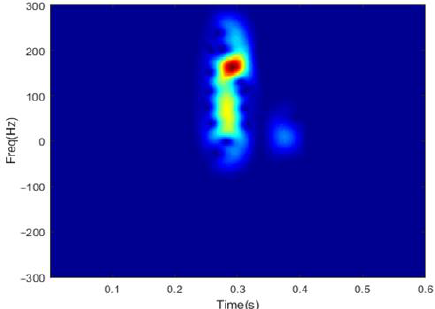
Figure 4. Spectrogram of reconstructed signal using the DGS-SP algorithm.